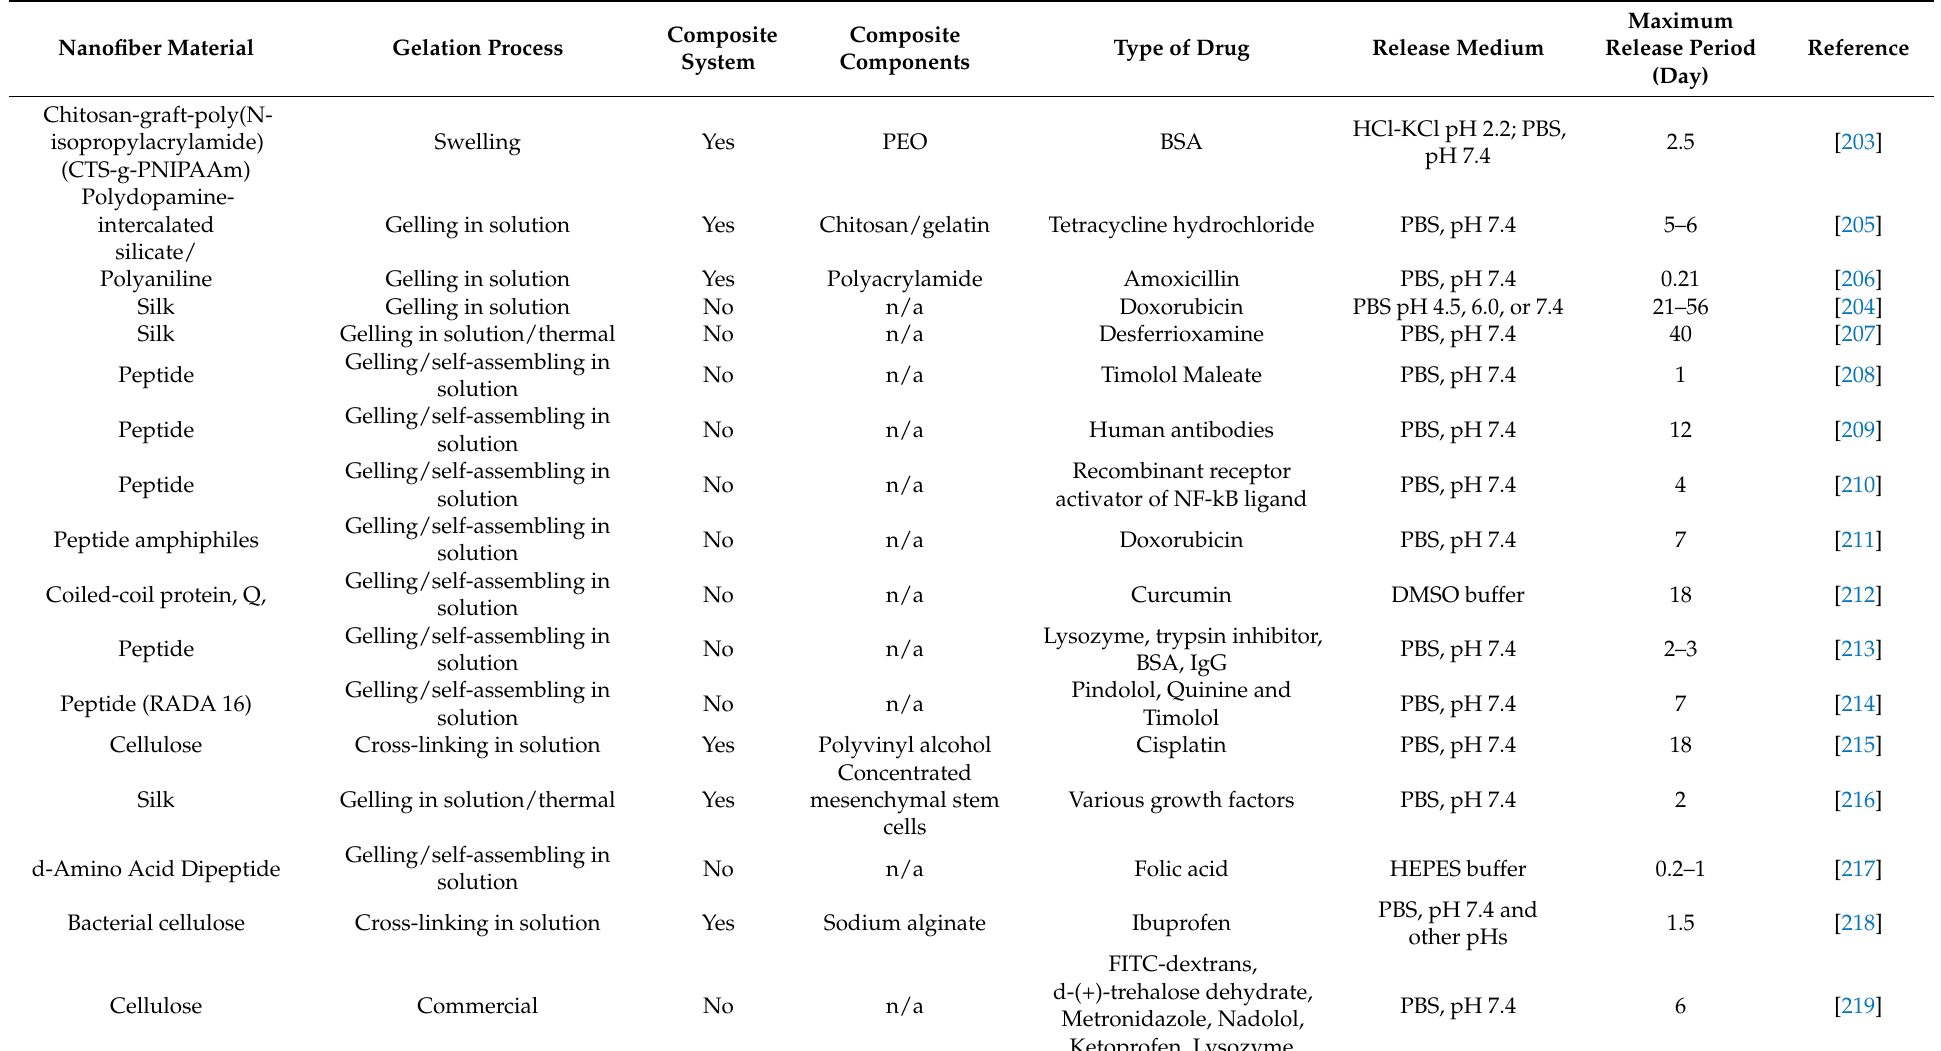
Table 5. Sustained drug release studies of nanofiber